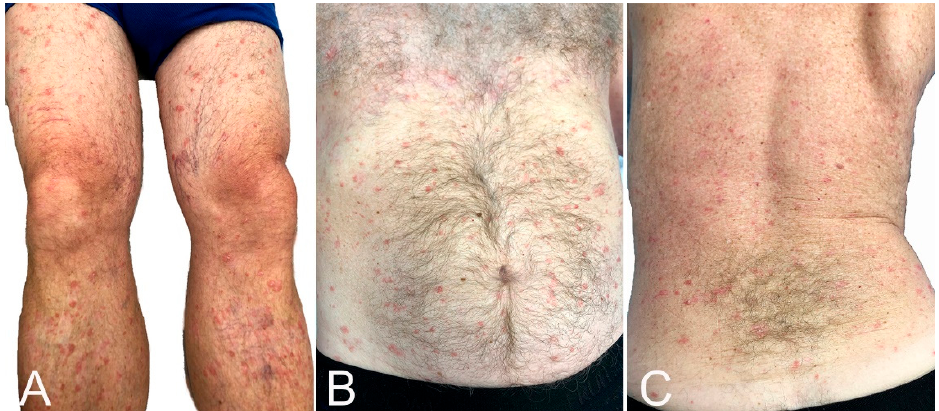
Figure 6. Psoriasis flare: lesions were limited to legs ( A ), but became generalized, affecting the thighs, trunk ( B , C ) and upper extremities 5 days after BNT162b2 vaccination.